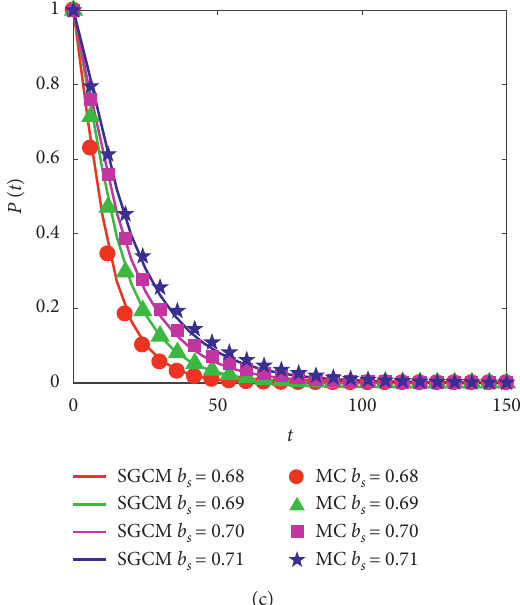
Figure 7: (a) Probability density function of FPT of system (6): D � 0 . 20, λ � 0 . 20. (b) MFPT of system (6): D � 0 . 20, λ � 0 . 20. (c) Reliability function of system (6): D � 0 . 20, λ � 0 .